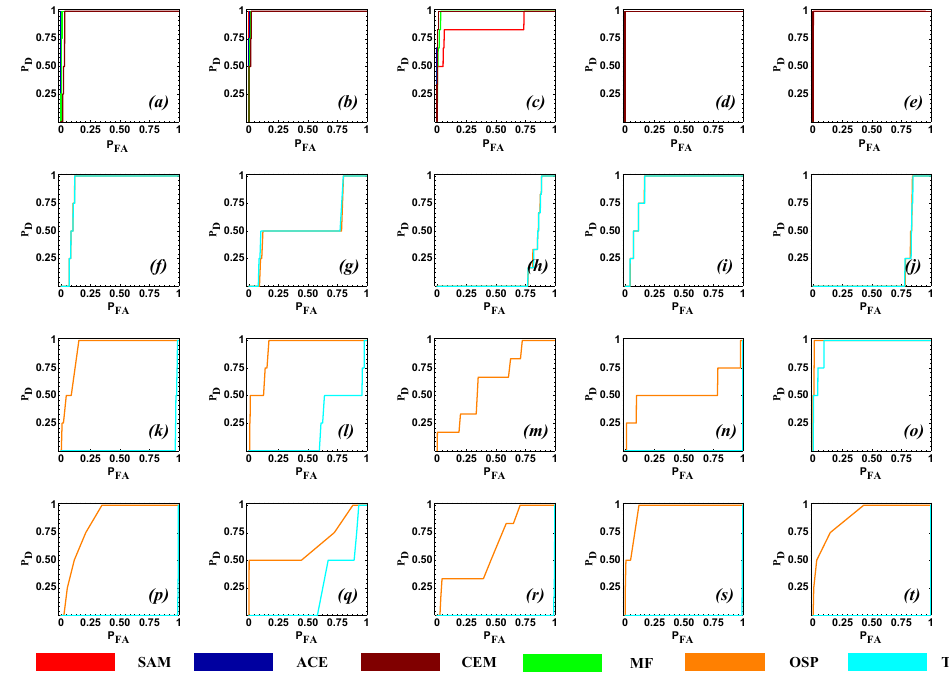
Figure 17. Target detection performance comparison in space-borne imagery for the airborne target reference spectra. ROC curves for the detection from SAM, ACE, CEM, and MF for the ( a ) N1G, ( b ) N2R, ( c ) N3Y, ( d ) C1W, and ( e ) N4B targets. ROC curves for the subspace-based detector OSP and TCIMF for the N1G, N2R, N3Y, C1W, and N4B targets for ( f – j ) 5, ( k – o ) 10, and ( p – t ) 15 endmember/background materials.